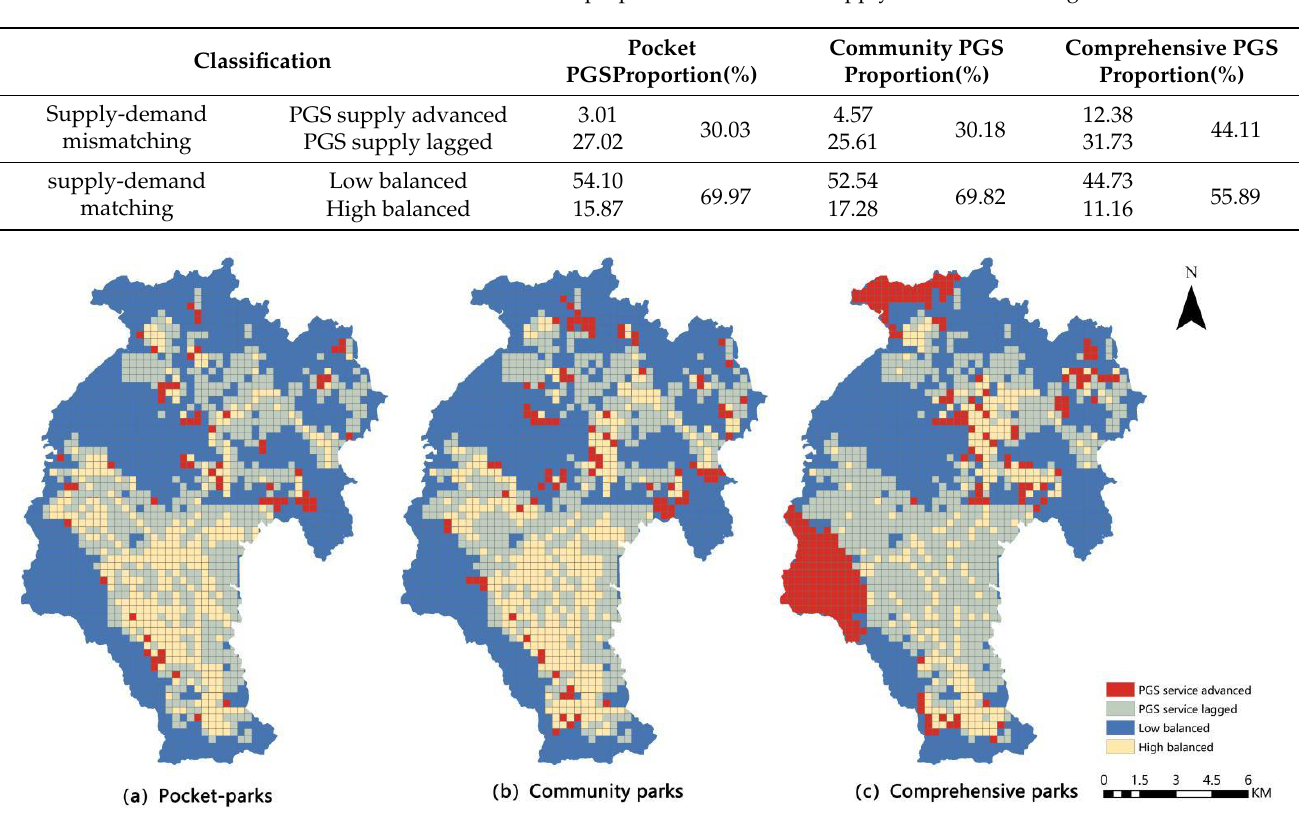
Figure 7. Spatial patterns of PGS-SED supply-demand matching.